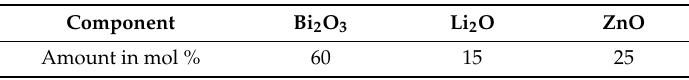
Table 1. Composition of Bi 2 O 3 -Li 2 O-ZnO glass